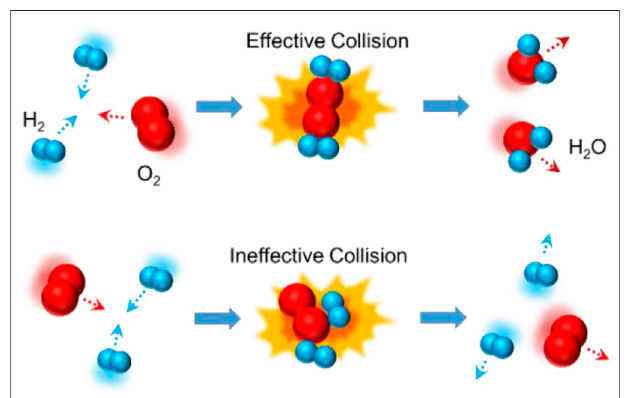
FIGURE 2 | Schematic diagram of the collision model for reactions between H 2 and O 2